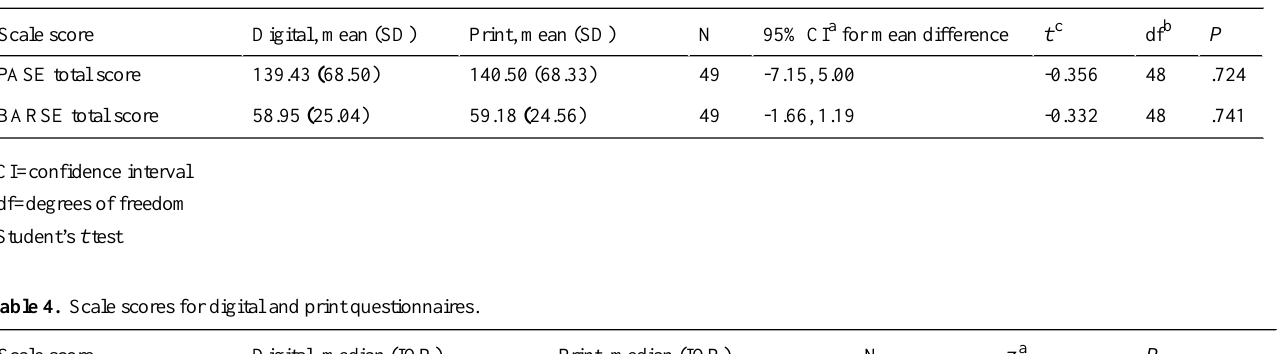
Table 3. Scale scores for digital and print questionnaires.